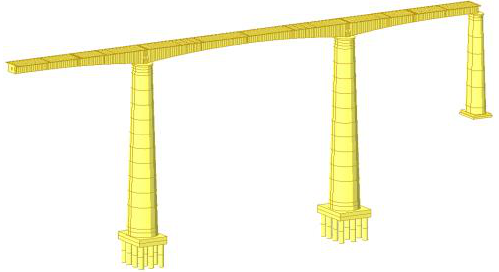
Figure 13. Three-dimensional FE model of Yexihe Bridge.